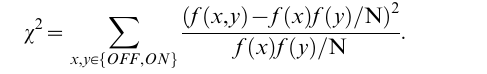
Table S1 Yeast strains used in this study. Table S2 Plasmids used in this study. Table S3 Fluorescence intensity in PEV strains. (A) Fluorescence intensity in TEL-VR PEV/Euchromatin (FUY355). The circle at on the upper left side indicates the first single cell, which was designated Cell No. 1 in this table (related Figure 5A). (B) Fluorescence intensity in HMR -right PEV/Euchromatin (FUY356) (related Figure 5C). (D) Fluorescence intensity in HML -right PEV/ Euchromatin (FUY795) (related Figure 5D). Table S4 Statistical analysis of the reproducibility of transitions of the gene expression state at the HMR -left PEV. HMR -left PEV Table S5 Statistical analysis of the reproducibility of transitions of the gene expression state at the TEL-VR PEV. TEL-VR PEV Table S6 Fluorescence intensity in histone-modified enzyme deletion strains. (A) Fluorescence intensity in HMR -left PEV/ (related Figure 7B). (C) Fluorescence intensity in HMR -left PEV/ Table S7 Fluorescence intensity in PEV strains with three different fluorescence proteins. (A) Fluorescence intensity in HMR -left PEV/ Figure S3C). (D) Fluorescence intensity in cells transformed with Figure S3D). (E) Fluorescence intensity in HML -right PEV/ HMR - right PEV/Euchromatin (FUY810) (related Figure